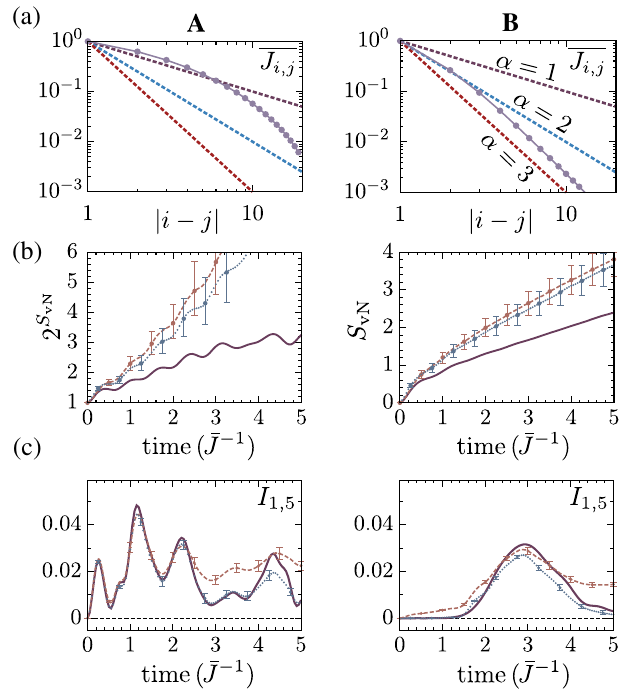
FIG. 6. (a) The averaged normalized interactions for the two experimental setups (grey dots). In case A , interactions decay with (cid:1) < 1 over short distances; in case B , they decay as (cid:1) (cid:3) 2 . (b) The evolution of the half-chain von Neumann entropy S vN (exponential scale for case A ) in a system with 20 ions (ED). The solid line is the idealized noiseless case. The dashed lines in (b) ¼ and (c) are for fluctuations of the magnetic field with s 1 0 : 01 = (cid:1) J ; the dotted lines in (b) and (c) are for fluctuations in ¼ 0 : 01 = (cid:1) J (200 noise trajectories). the coupling strength with s 2 . The character- (c) Time evolution of the mutual information I 1 ; 5 istic features of the two entanglement growth regimes survive in the presence of the